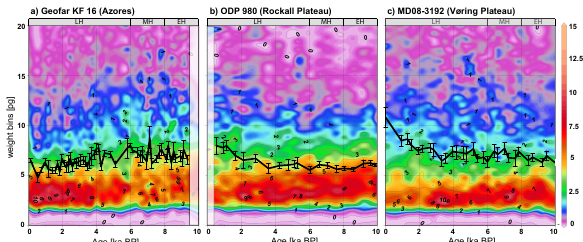
Fig. 2. (a) Azores, core Geofar KF 16; (b) Rockall Plateau, ODP site 980; and (c) Vøring Plateau, core MD08-3192. Abundance of Noelaerhabdaceae coccoliths within weight bins (colours) and Noe- laerhabdaceae mean coccolith weight (black line). For the weight bins the data set has been divided into classes (bins) with a step of 0.4pg: each bin contains the frequency of data points in per- cent of each sample from the Holocene data set. Error bars indicate 95% confidence intervals of the mean weight. Abbreviations: early Holocene (EH), middle Holocene (MH), late Holocene